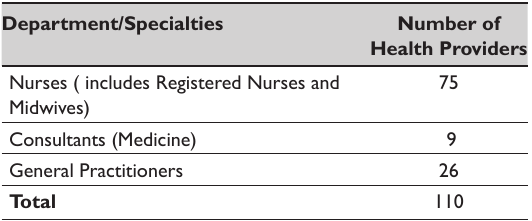
Table 1: Specialty and Categories of Health Care Providers in the